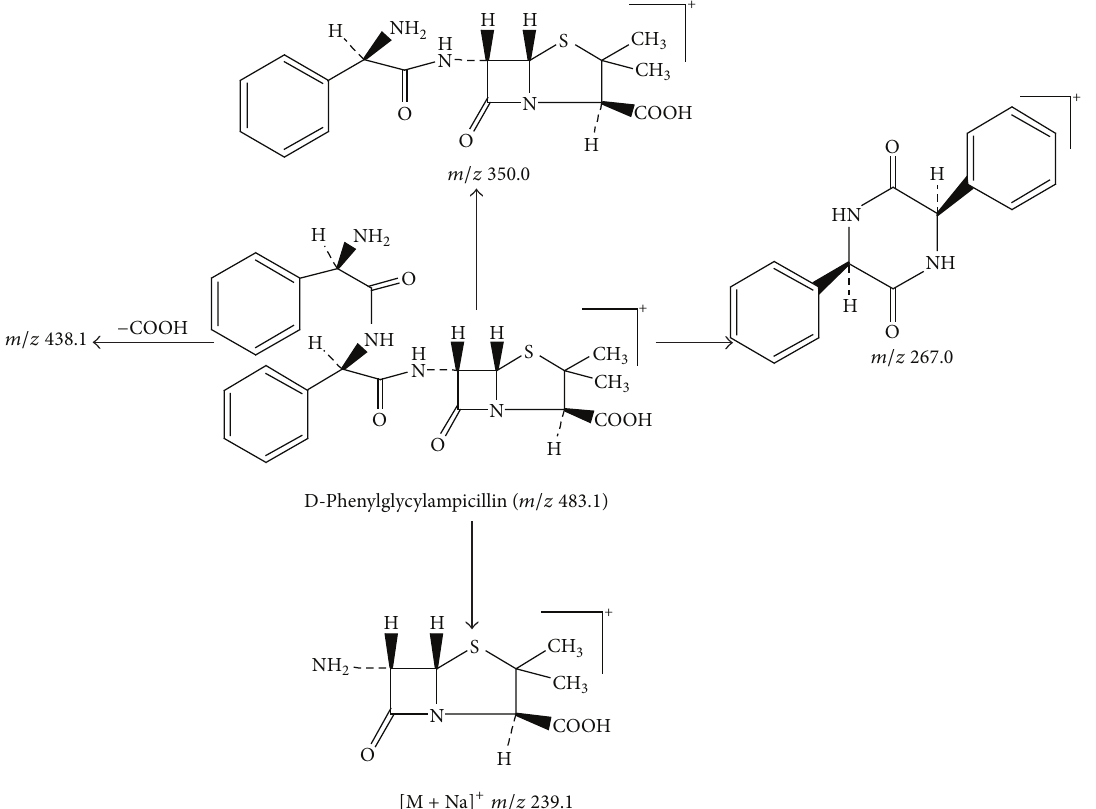
Figure 8: Proposed fragmentation pathway for the fragmentation ion of D-phenylglycylampicillin.